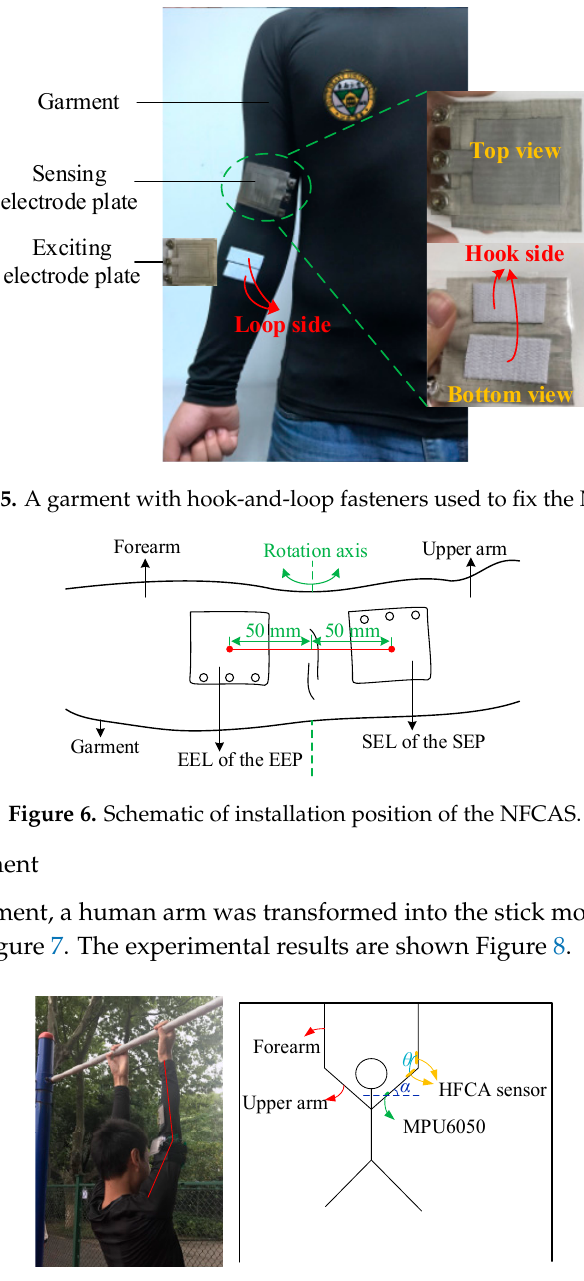
Figure 7. The detection model of pull-ups.